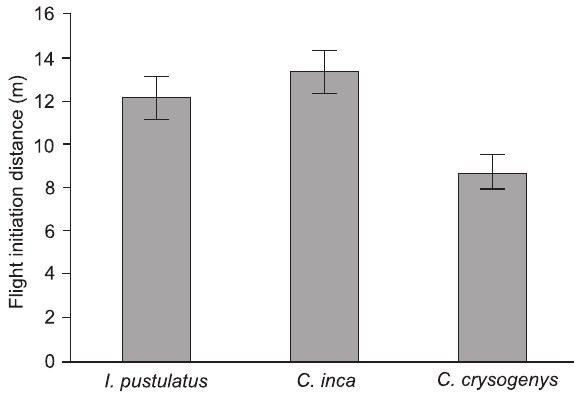
Figure 1. Mean (± SE) flight initiation distance scored in the three avian species